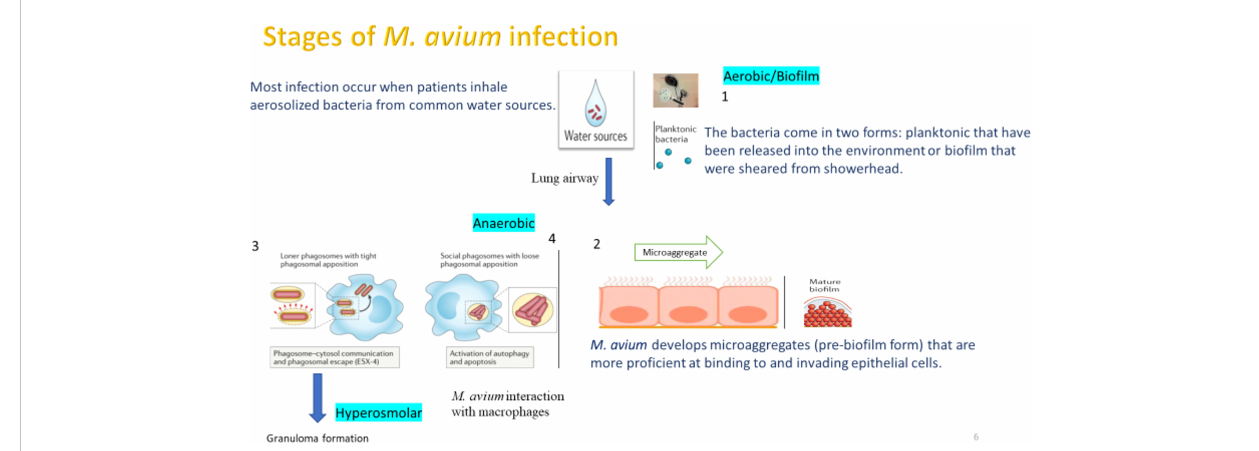
FIGURE 1 Main stages and phenotypes of M.avium causing a lung airway infection. The fi rst stage M. avium reaches the airways in planktonic or bio fi lm forms. We established a model to understand the stages that both planktonic and bio fi lm phenotypes encounter during the infection. A key assumption of the model is that the pathogen that takes a long time to synthesize proteins, does need a “ core pathways ” to keep the metabolism active and by connecting with pathways exclusive to the different phenotypes allow for transitions needed to synthesize proteins required for the bio fi lm as well as the intracellular